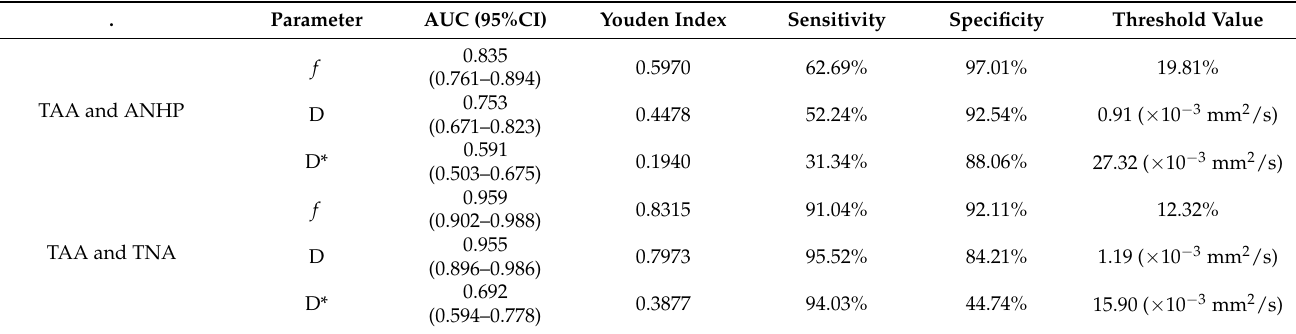
Table 5. Diagnostic capability of IVIM parameters for distinguishing different tissues.